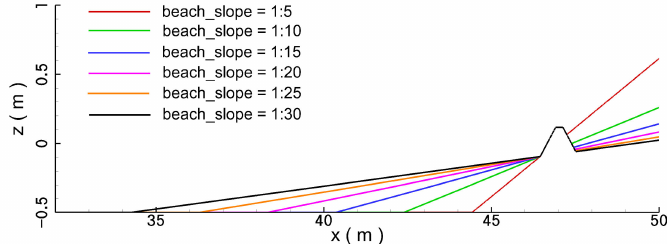
Figure 29. Computational layout for seawalls with different beach